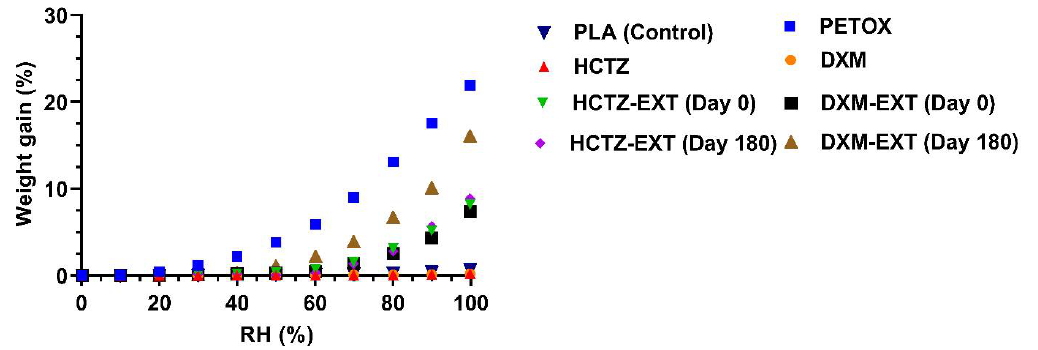
Figure 5. Moisture sorption of the drugs, PETOx, PLA, and crushed drug-loaded extrudate powders at a temperature of 25 °C.